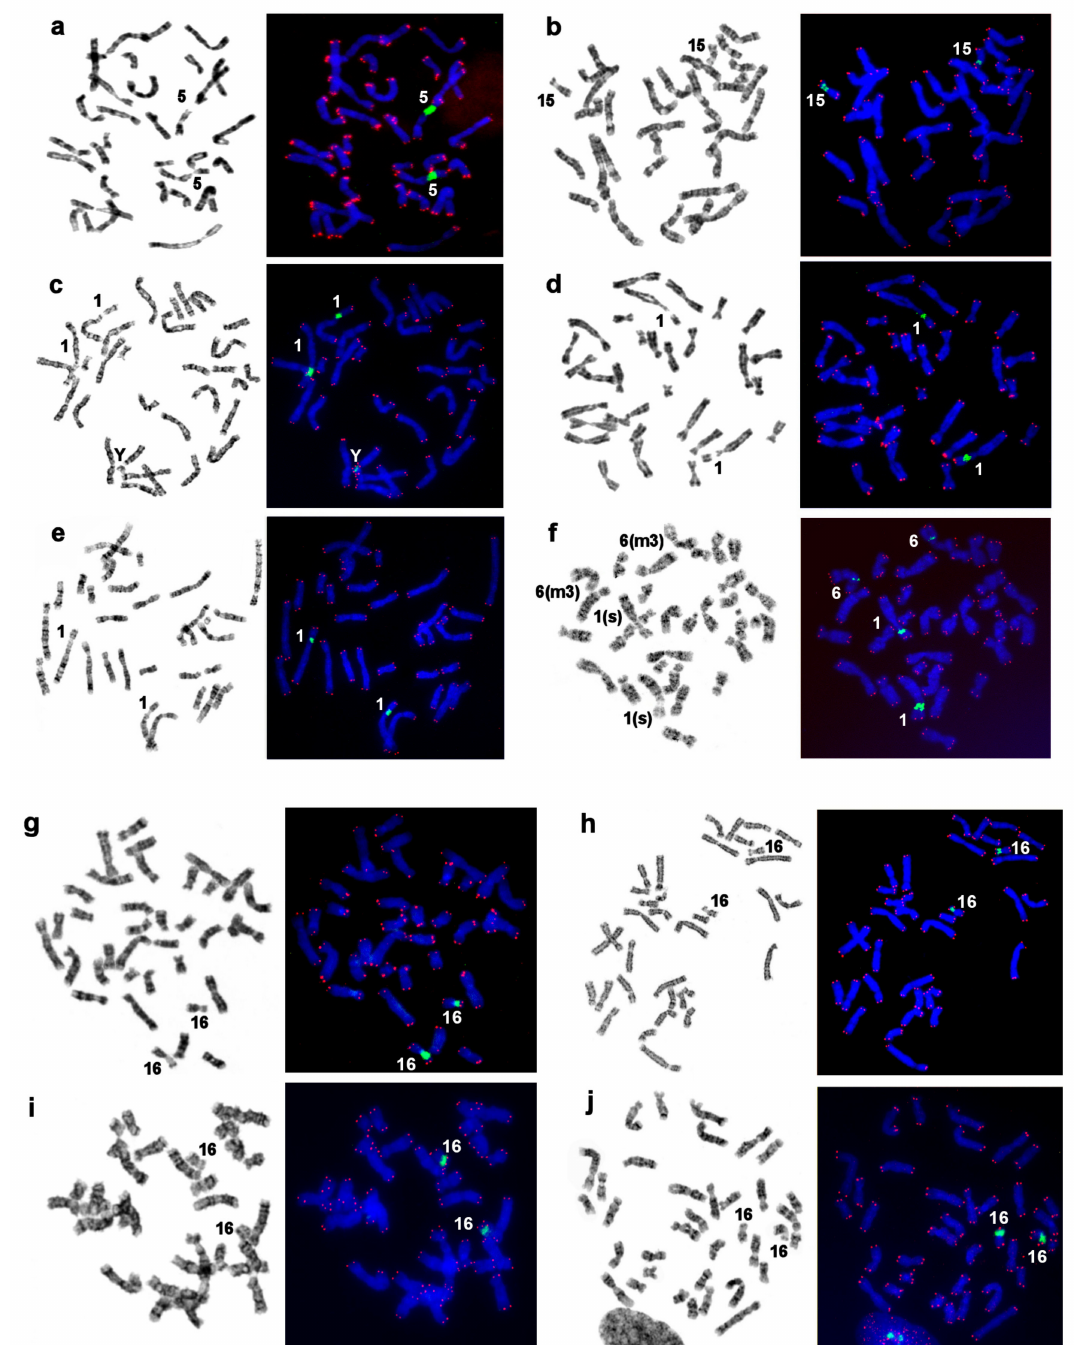
Figure 7. Distributions of telomeric repeats and rDNA clusters on chromosomes of pinnipeds. G-banding (left) followed by FISH (right) of a telomeric probe (TTAGGG) n (red) and an 18S, 5.8S, and 28S rDNA probe (green) on DAPI-stained chromosomes. ( a ) The walrus and true seals, ( b ) the bearded seal, ( c ) ringed seal, ( d ) spotted seal, ( e ) Baikal seal, and ( f ) harbor seal. The telomeric probe highlighted the termini of all chromosomes in the investigated species. Note di ff erences in the size and signal intensity on telomeres (some were very faint) in species, with the walrus’s telomeric blocks being larger than those in the other species. No interstitial telomeric sites marking fusions of ancestral elements were detectable in pinnipeds here [33]. The chromosome numbers are indicated for NOR bearing chromosomes. NOR sizes vary between homologs among several species. The eared seals: ( g ) the New Zealand fur seal, ( h ) northern fur seal, ( i ) New Zealand sea lion, and ( j ) northern sea